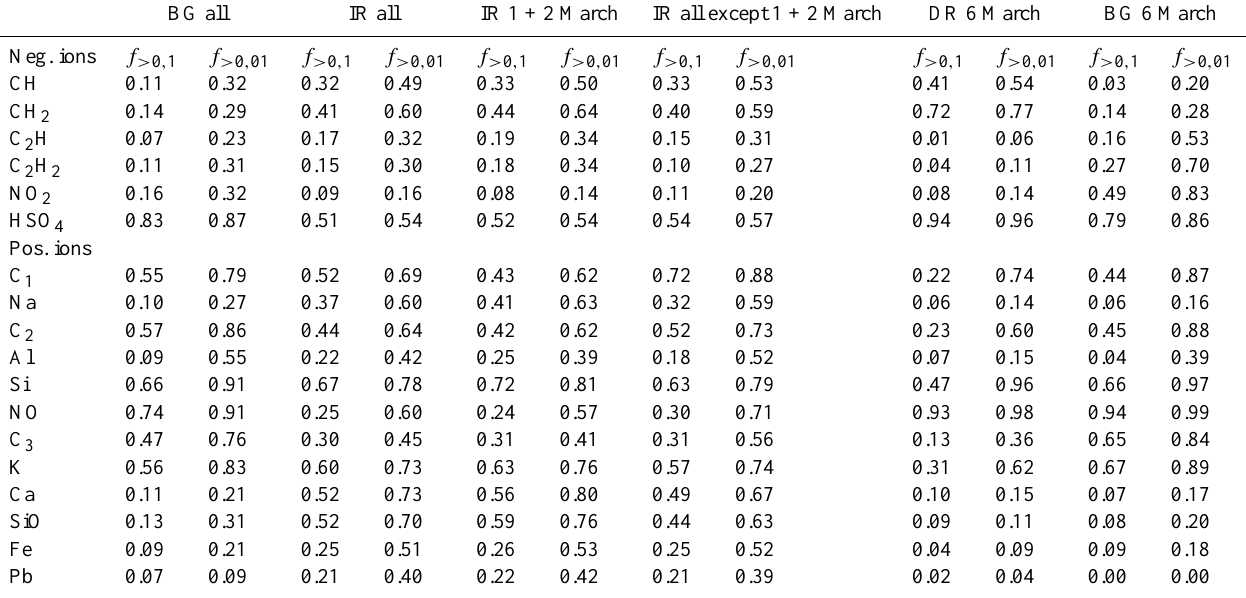
Table 1. Frequency of occurrence of a signal strength of > 10% ( > 1%, respectively) for the listed ion compared to the largest peak of the spectrum for the SPLAT data; example: in 11% of all background particle spectra the CH − peak was at least as high as 10% of the highest peak of the spectrum (normalized intensity >